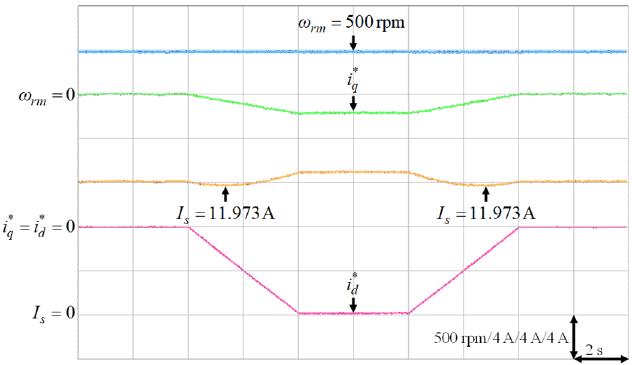
Figure 16. Experimental results of finding the lowest stator current at 500 rpm with 6 Nm.